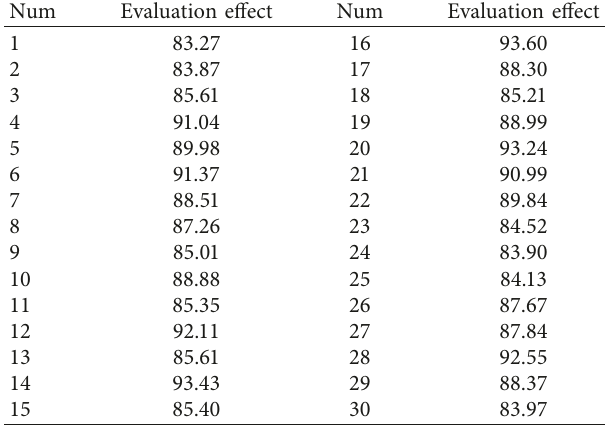
Figure 10: Comparison of the effects of the English teaching evaluation system.